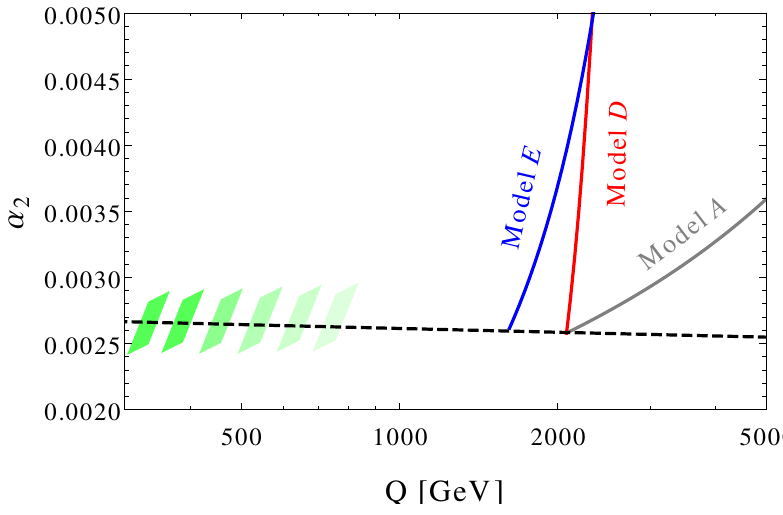
Figure 17 . SM running of the weak coupling constant (black dashed line) and schematically indicated by the green hatched band the region where the weak sector of the SM has passed exper- imental tests, see text for details. Colored solid lines indicate the running of (cid:11) 2 in asymptotically safe benchmark scenarios introduced in table 7 that allow for a low matching scale around 1 : 5 to 2 TeV.